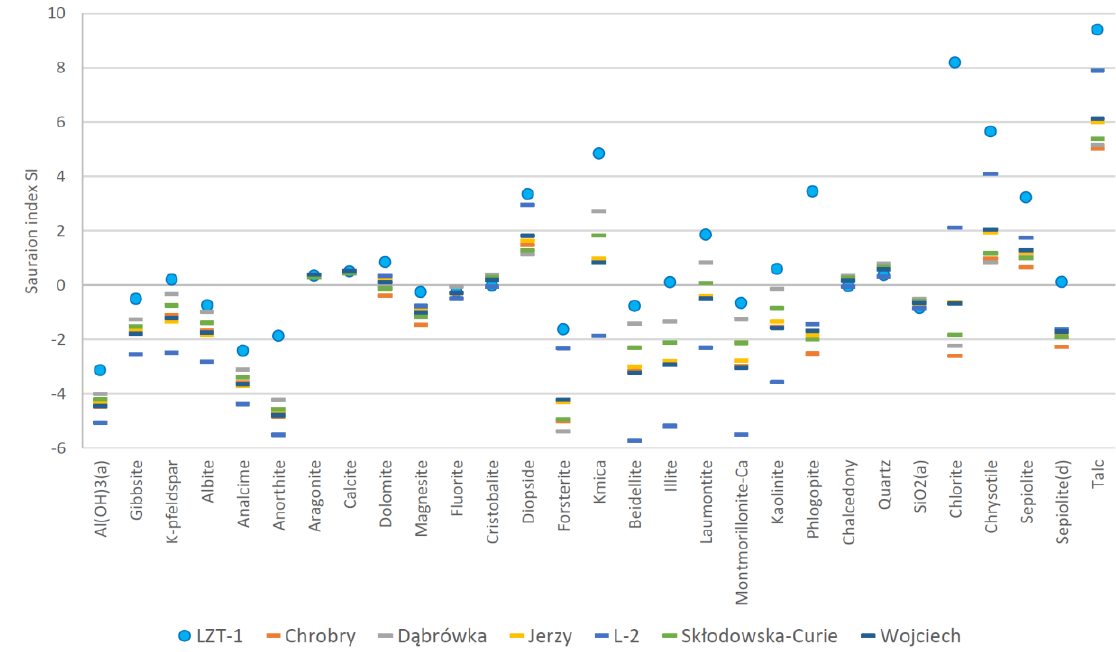
Figure 9. The saturation index (SI) of thermal waters for the selected minerals in the Lądek-Zdrój area (based on [44]